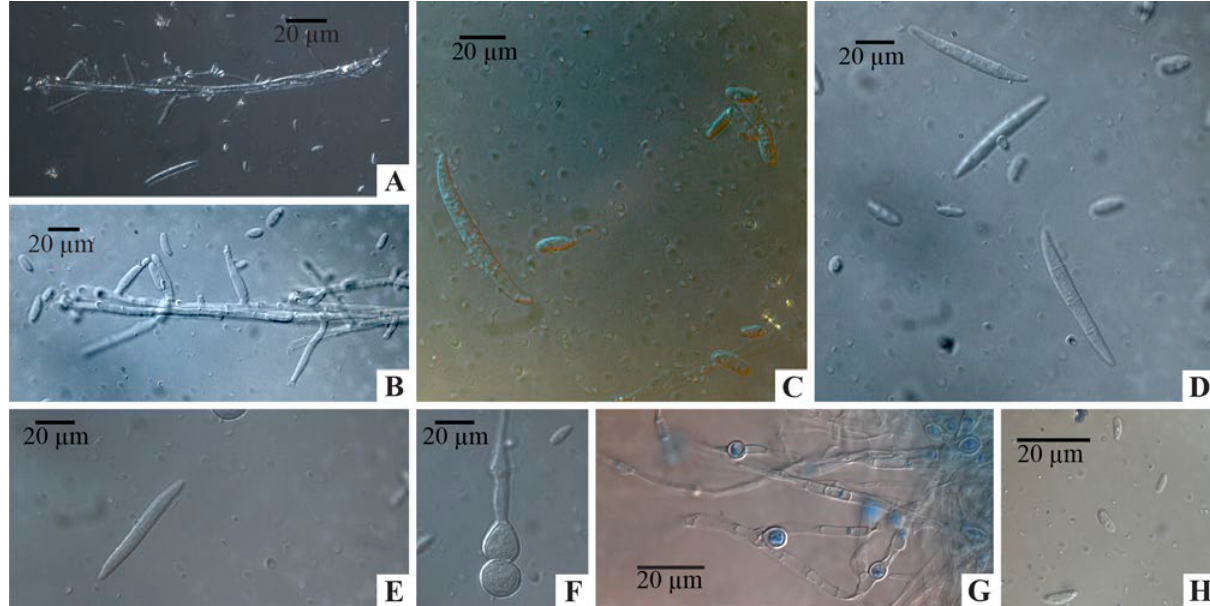
Figure 2. Morphological characteristics of a teak-infecting Fusarium oxysporum isolate. Conidiophores and phialides (a and b). Microconidia (oval to ellipsoid and slightly curved) with no septae (a, b, c, d, and h). Falcate and slightly curved macro- conidia with three to five septae (c, d, and e). Globose to oval chlamydospores formed at the ends of hyphae or interspersed in the mycelium, which were found single, in pairs, or in chains (f and